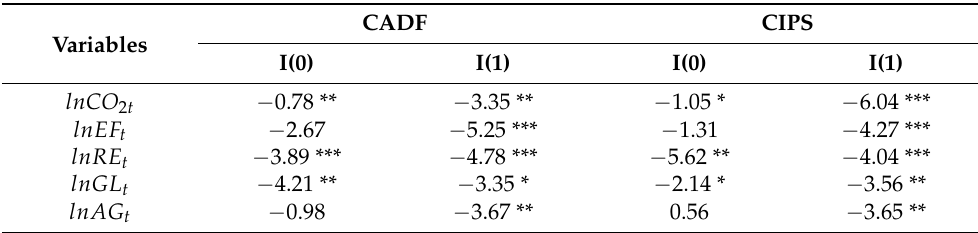
Table 4. Unit root tests.